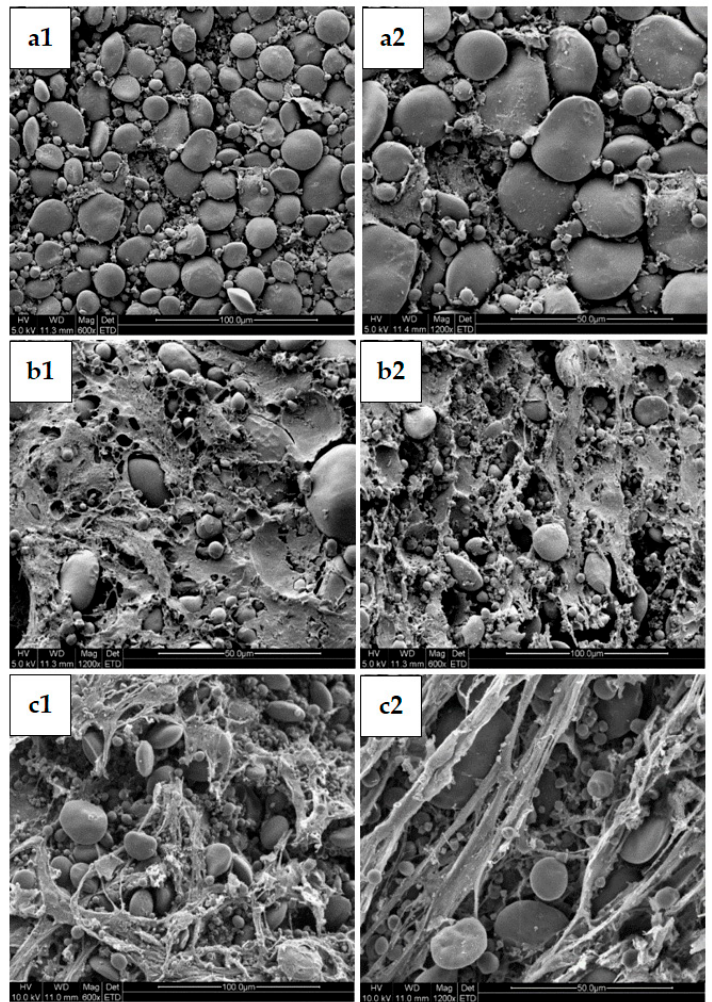
Figure 7. Scanning electron micrographs (SEMs) on proofed dough with different acidification levels: ( a1 , a2 ) added 4 h fermented sourdough; ( b1 , b2 ) added 12 h fermented sourdough; ( c1 , c2 ) added 20 h fermented sourdough.